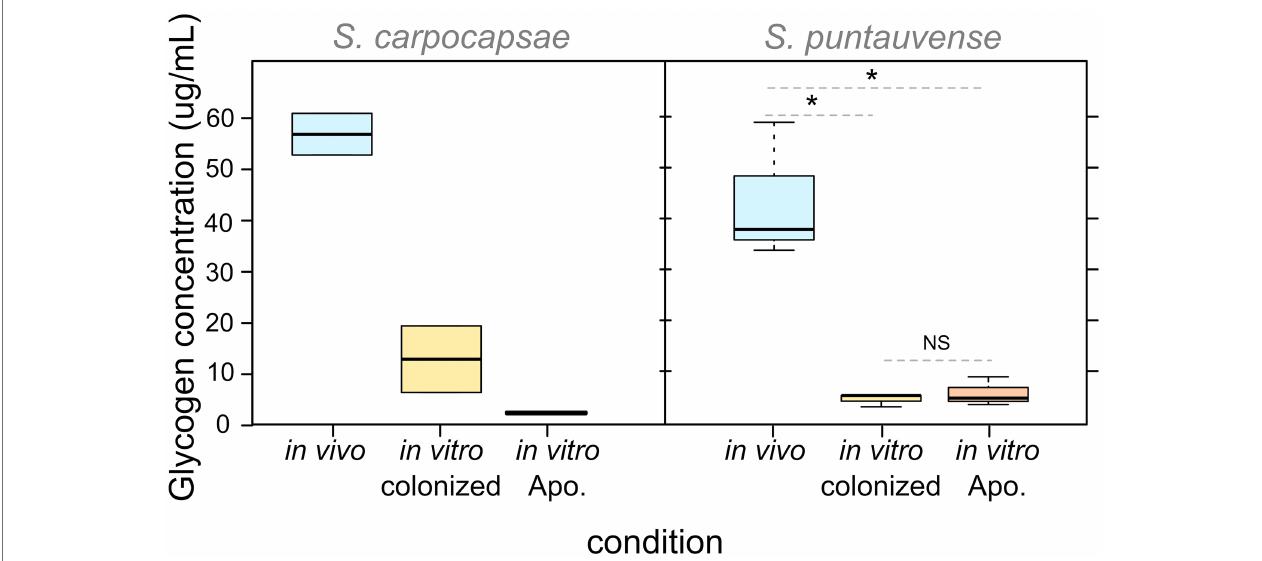
FIGURE 5 | Boxplot of glycogen concentration detected in pool of 10,000 IJs reared in the three studied conditions ( in vivo , in vitro colonized, and in vitro aposymbiotic). Their differential expression was tested by a non-parametric Kruskal-Wallis rank sum associated with multiple pairwise comparisons using the Dunn’s test (see detail in Supplementary Table S5 ). Asterix (*) indicates significant difference (value of p < 0.05), “NS” indicates no significant difference. Statistical tests were not performed on S. carpocapsae data due to the low number of